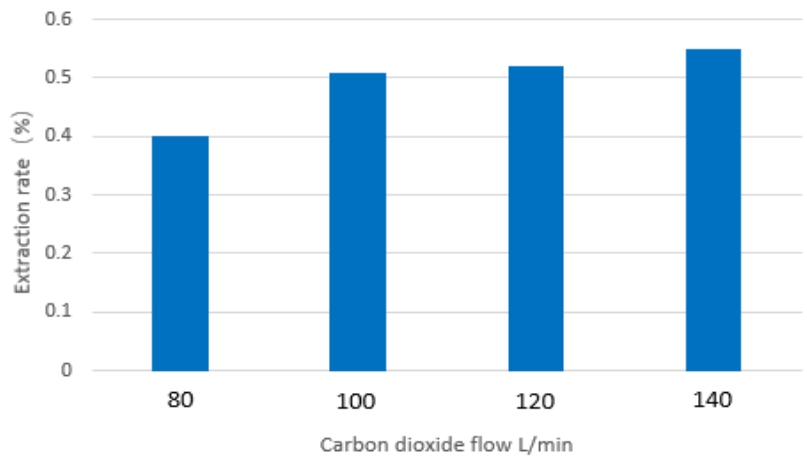
Figure 6. Effect of the CO 2 flow rate on the extraction rate.